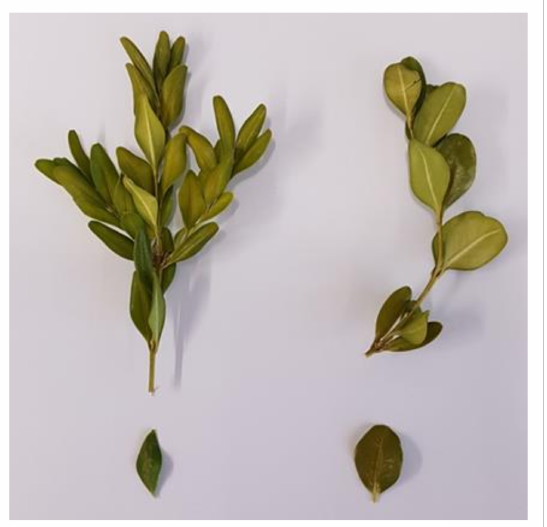
Figure 10. Left: Shoot tip and single leaf of B . sempervirens var. arborescens L.; right: shoot tip and single leaf of B . sempervirens var. suffruticosa